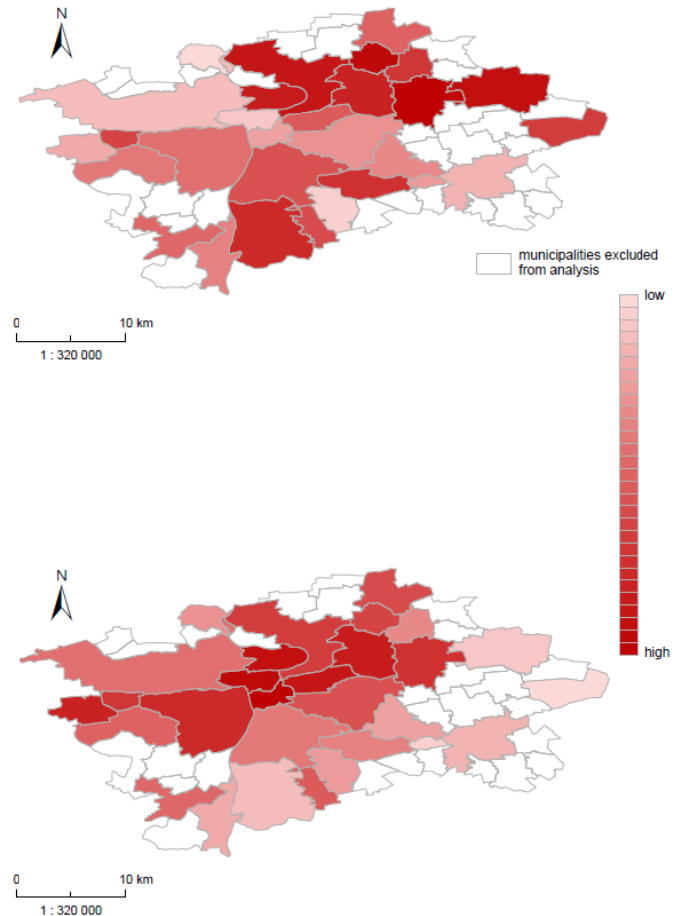
Figure 5. ( A ) High circulatory mortality & economic and social deprivation factor score in Prague MA. ( B ) High mortality & social and housing deprivation factor score in Prague